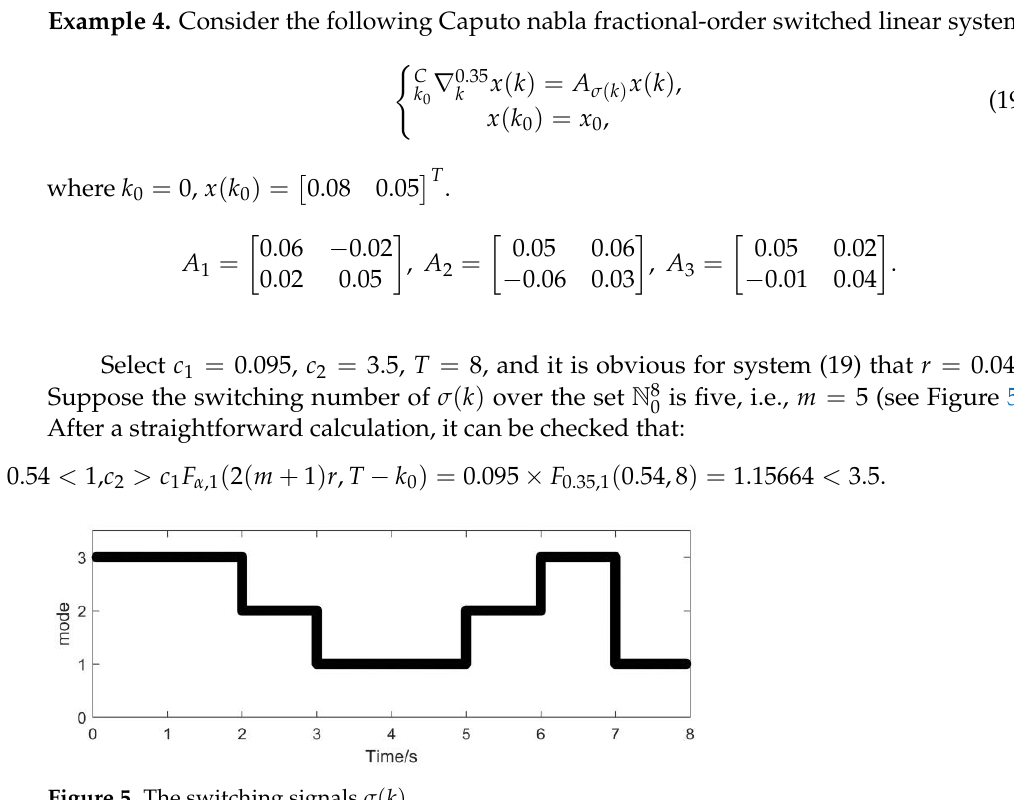
Figure 5. The switching signals σ ( k )